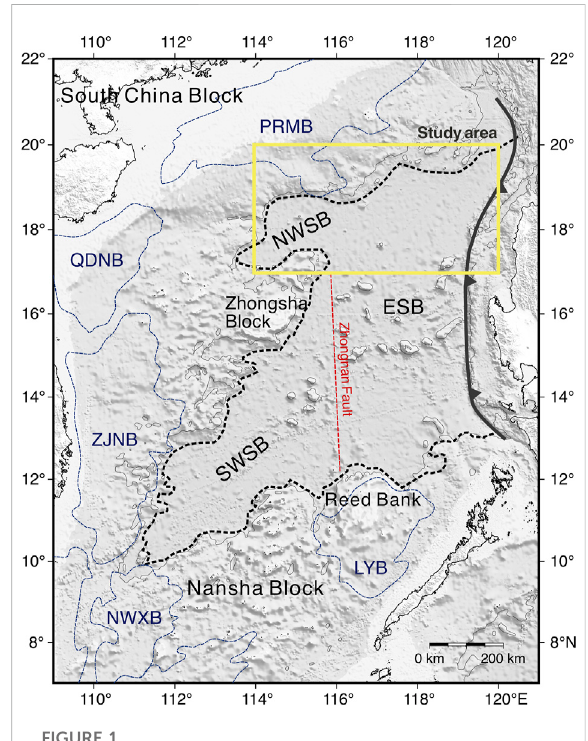
bluedashedlinesaretheboundaryofthebasin,andthethickblack dashed line is the COB bounded by the 10 km crustal thickness (Wu et al., 2017). NWSB: Northwestern sub-basin, ESB: Eastern sub-basin, SWSB: Southwestern sub-basin, PRMB: Pearl River Mouth Basin, QDNB: Qiongdongnan Basin,